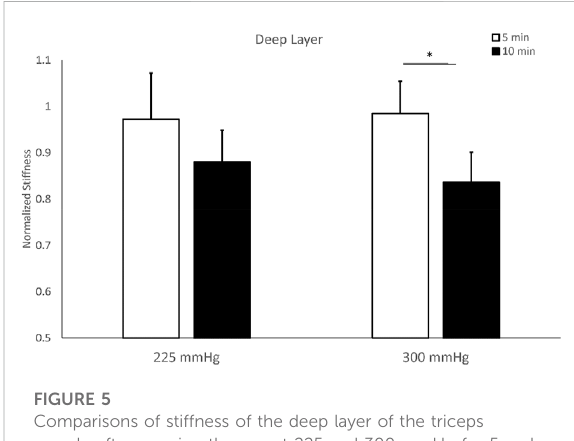
FIGURE 5 Comparisons of stiffness of the deep layer of the triceps muscle after cupping therapy at 225 and 300 mmHg for 5 and 10 min. For the deep layer of triceps, 10-min cupping therapy induces asigni fi cant decrease instiffnesscomparedto 5-min cupping. Comparedto pre-cupping